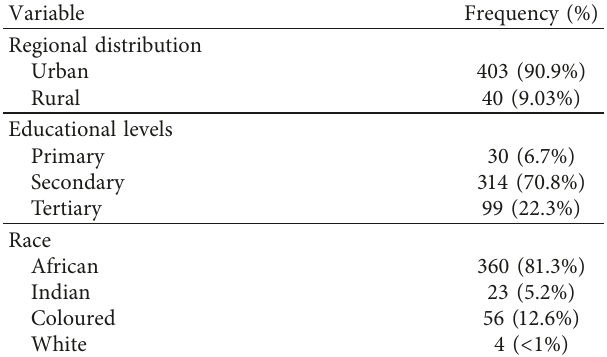
Figure 2: Frequency distribution of DMFT.